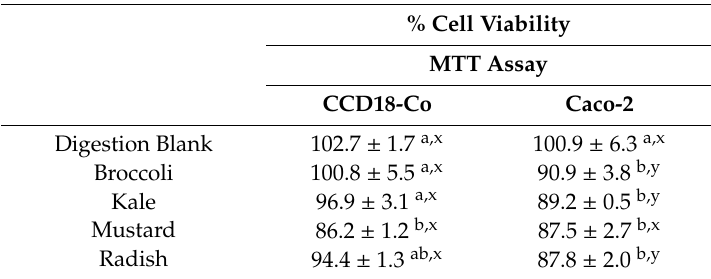
Table 2. Antiproliferative e ff ect of microgreen bioaccessible fractions (diluted 1:10 v / v in D-MEM) after 24 h treatment on normal (CCD18-Co) and / or tumoral (Caco-2)